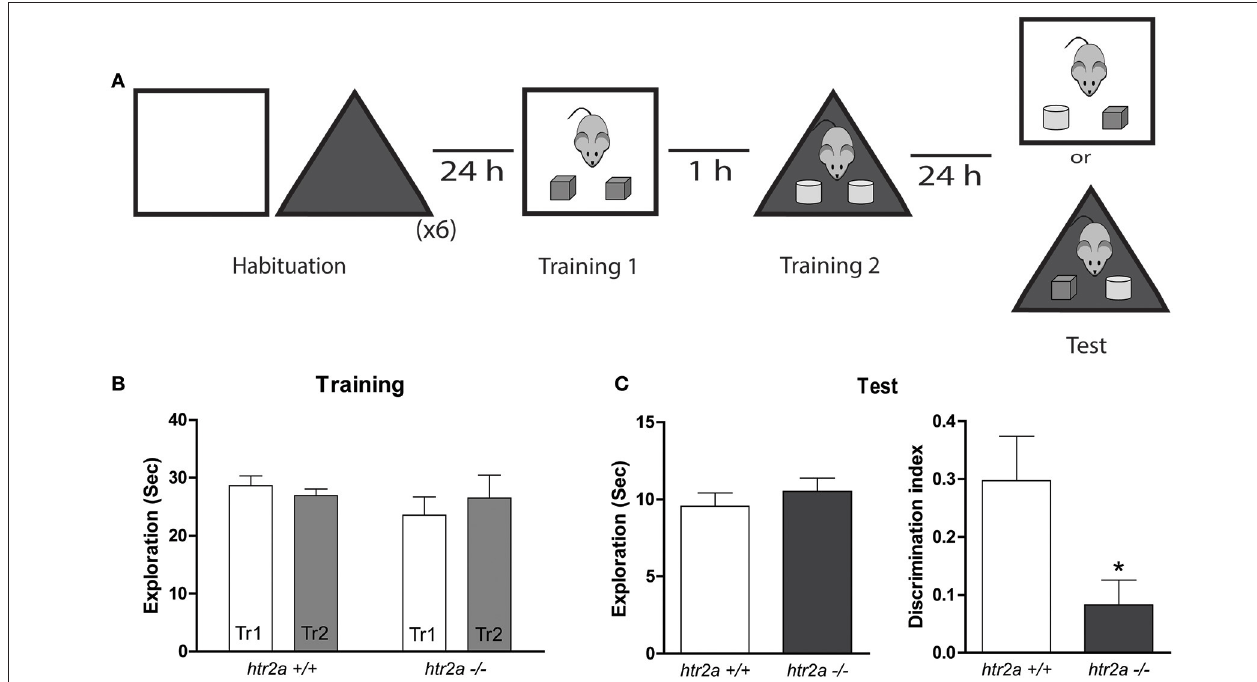
FIGURE 2 | 5-HT2aR is required for the object-in-context task. (A) Training and Testing scheme. Mice were exposed to a context containing two identical copies of an object. An hour later they were exposed to a different context containing two identical copies of a different object. Twenty-four hours later they were re-exposed to one of the context containing one copy of each of the objects. (B) Exploration time measured in seconds made by the mice during the first and the second Training phases (Tr 1 and Tr2). (C) Total exploration measured in seconds (left) and Discrimination Index (right). DI was calculated as the time spent exploring the incongruent object minus the time spent exploring the congruent object over the total exploration time during the test session. n = 10 –11 per group, * p < 0.05 , Student’s t -test.